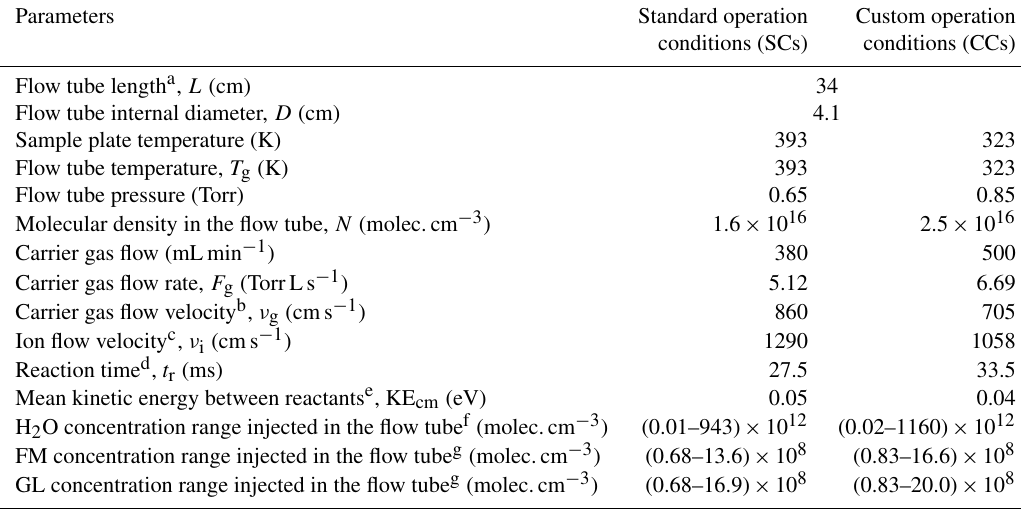
GL concentration range injected in the flow tube g (molec.cm − 3